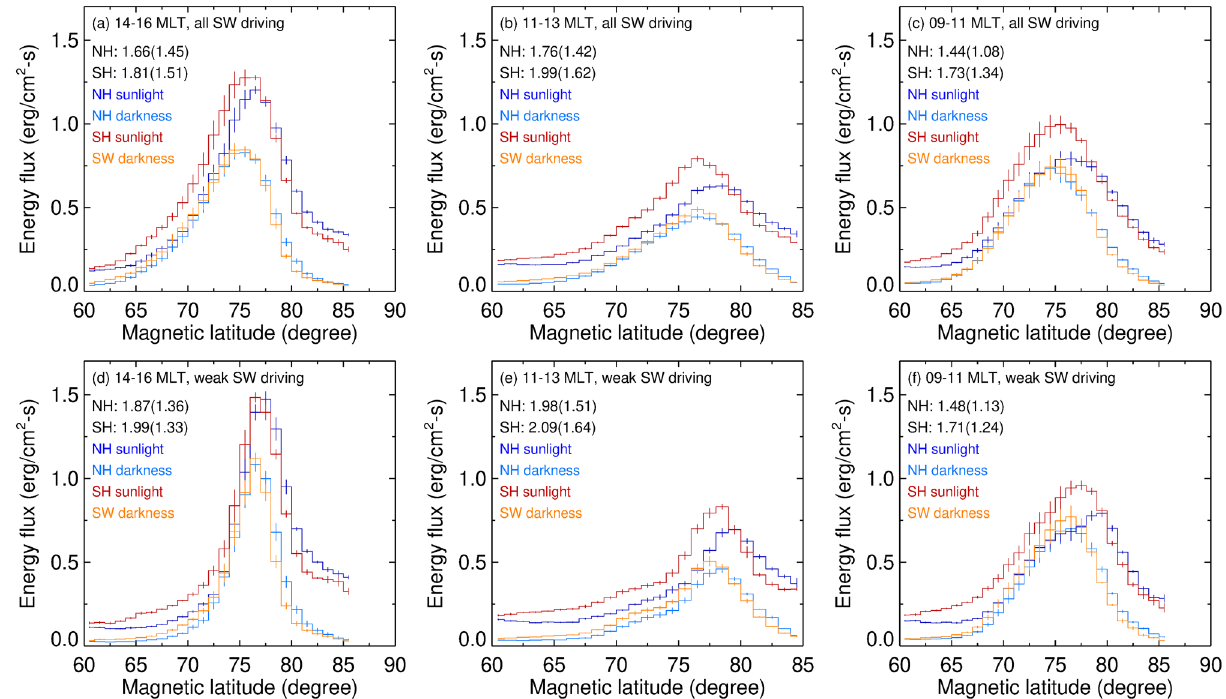
Figure 4. Comparisons of the latitudinal energy flux profile at ( a , d ) the 1,400–1,600 MLT, ( b , e ) 1,100–1,300 MLT, and ( c , f ) 0,900–1,100 MLT sectors for (top panels) all solar wind corresponding to Fig. 2 and (bottom panels) weak solar wind driving corresponding to Fig. 3. In each panel, blue is for sunlit NH, orange is for dark NH, red is for sunlit SH, and cyan is for dark SH. The vertical bar at each latitudinal bin represents standard deviation of the mean. The inserts in each panel are the sunlit-to-dark ratio of latitudinal integrated and peak (in the parenthesis) energy